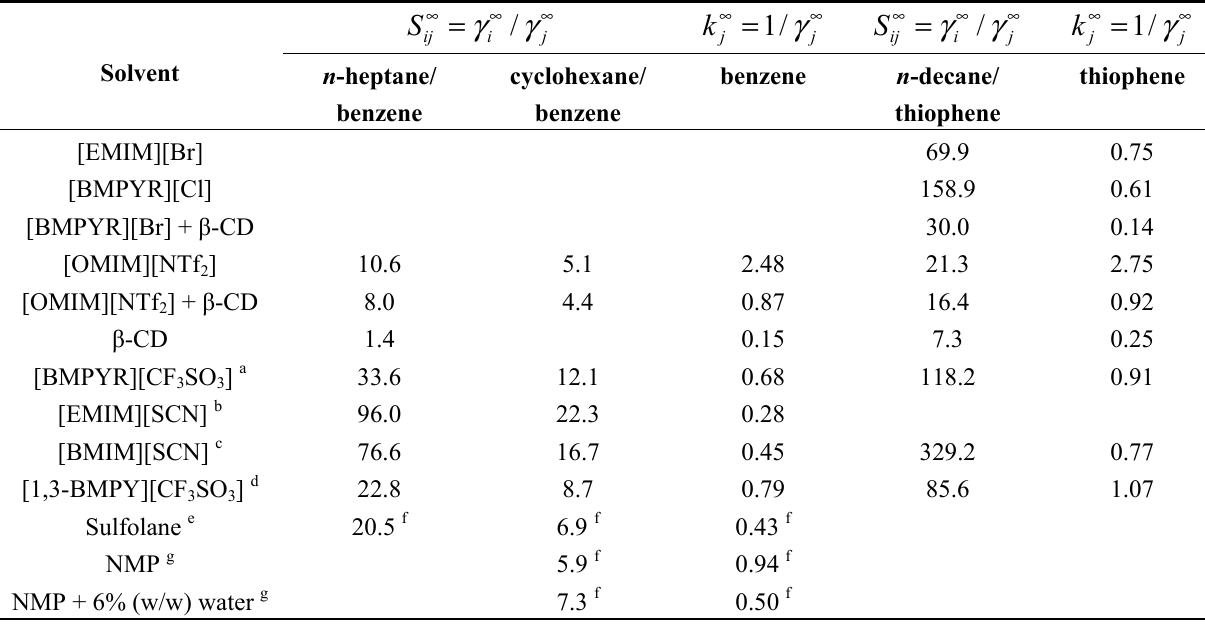
Table 5. Selectivities, ∞ S and capacities, ∞ k at infinite dilution for different ionic liquids ij j and the different separation problems at T = 338.15